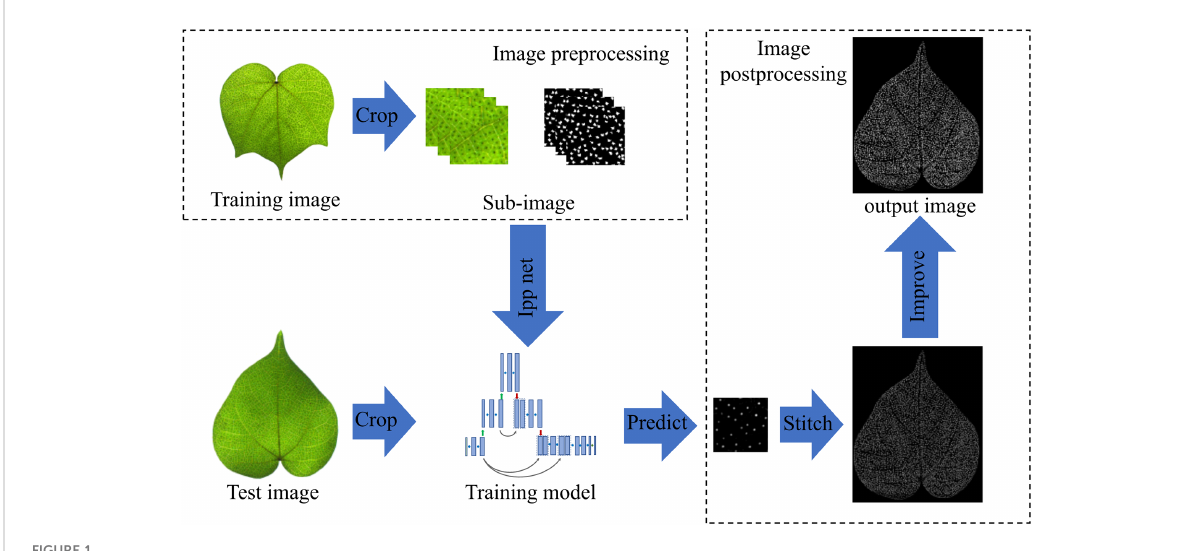
FIGURE 1 Flow chart of cotton pigment gland